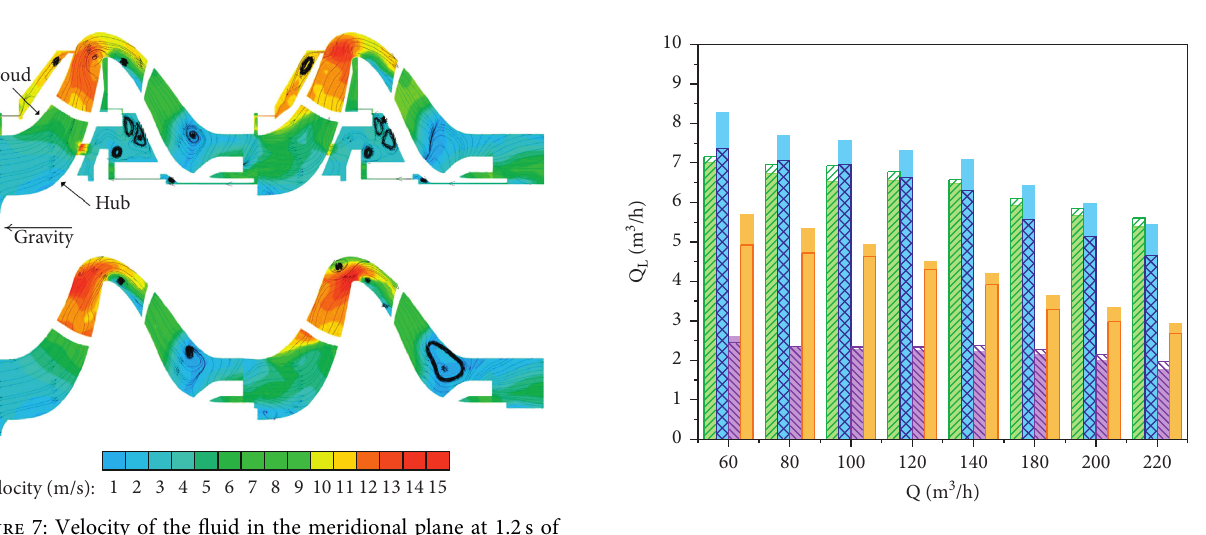
Figure 7: Velocity of the fluid in the meridional plane at 1.2s of pumps with or without leakage: (a) leak situation and (b) nonleak situation.